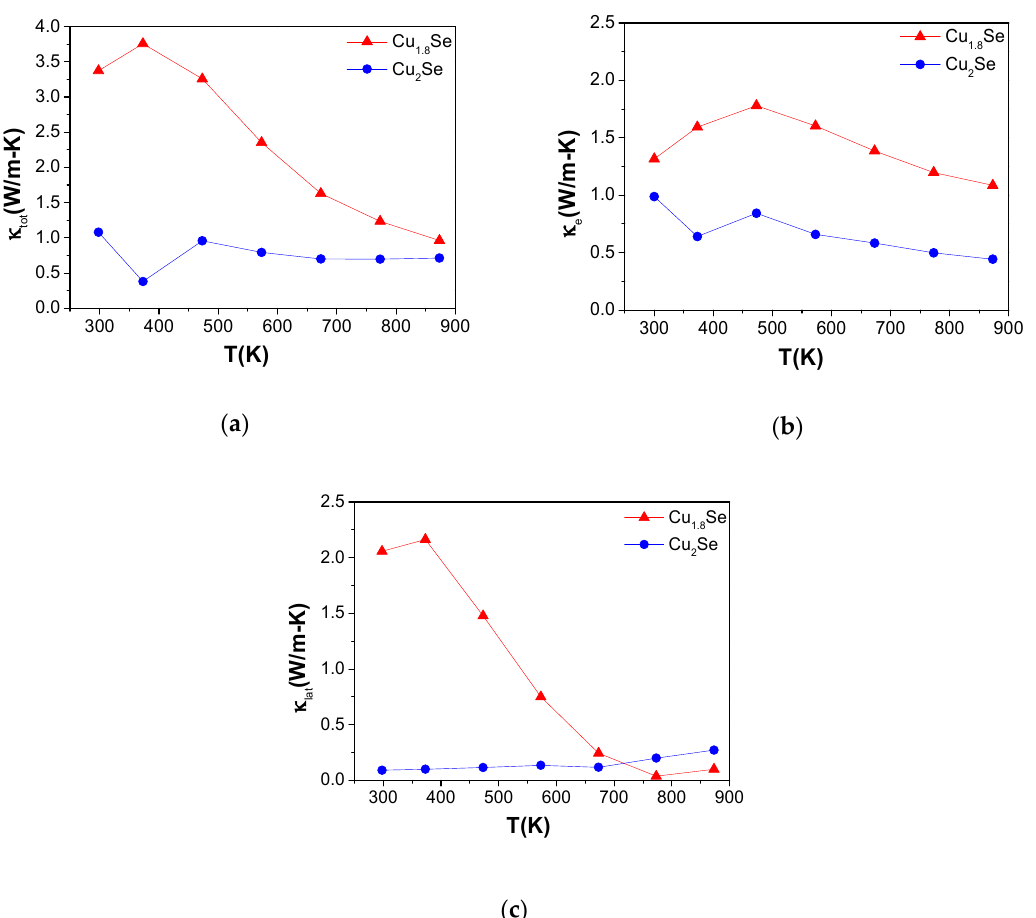
Figure 8. ( a ) Total κ tot , ( b ) electronic κ e , and ( c ) lattice κ lat thermal conductivity, as a function of temperature for Cu 1.8 Se and Cu 2 Se. The non-monotonous behavior of measured quantities in the temperature range of 300–400 K is due to the structural phase transition of Cu 2 Se.